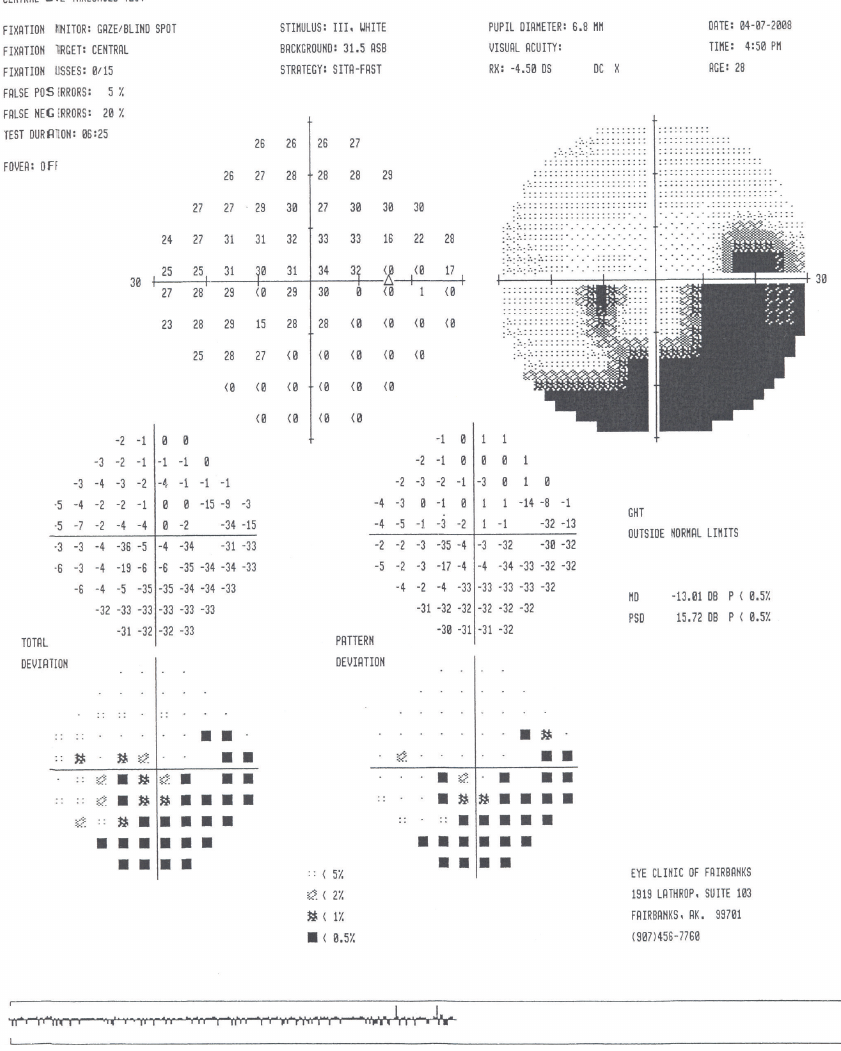
Figure 5: Visual field 30-2 (right